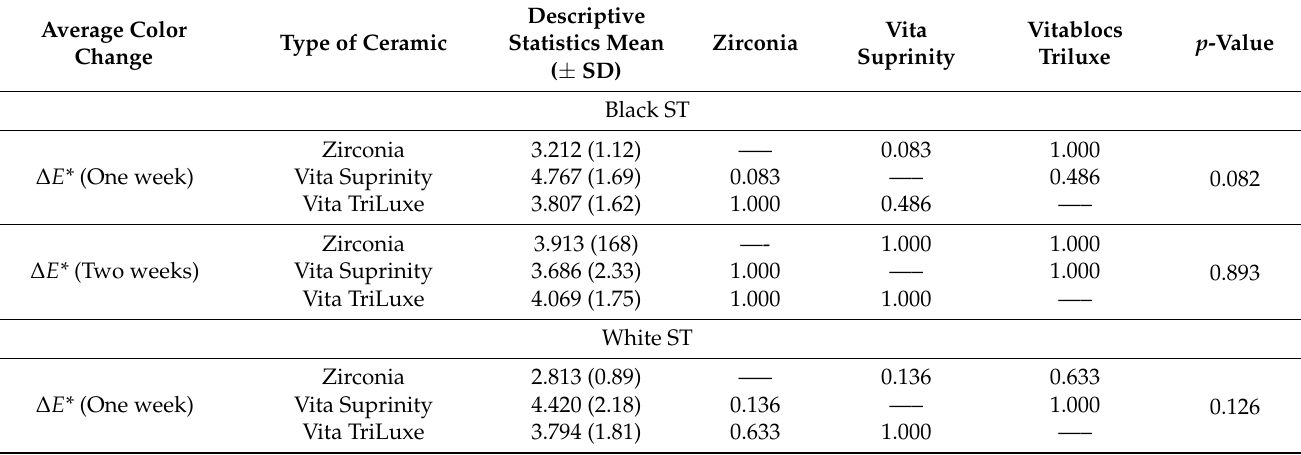
Table 1. Mean color change ( ∆ E* ) and SD values after staining in black and white ST for CAD/CAM ceramic materials ( n =